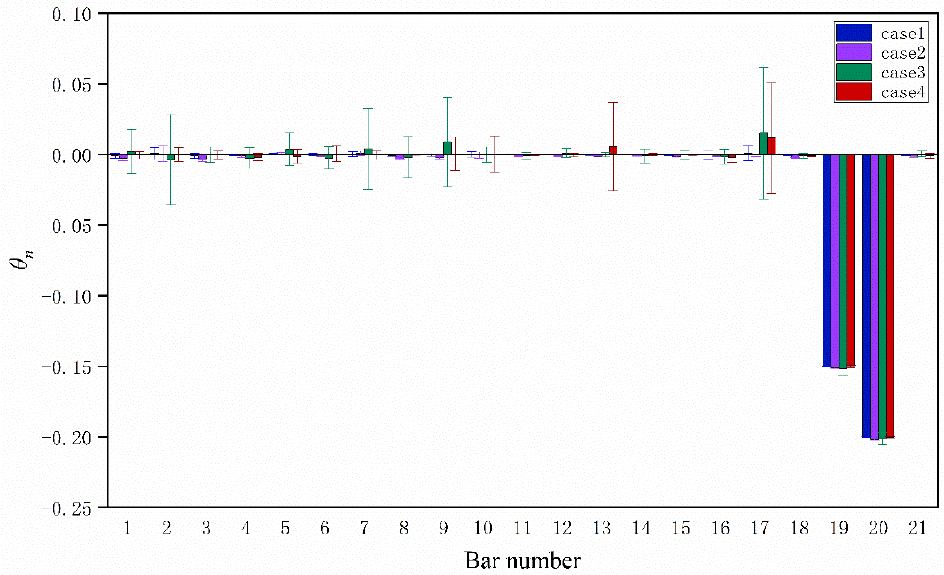
Figure 9. Updated stiffness parameters for truss model.